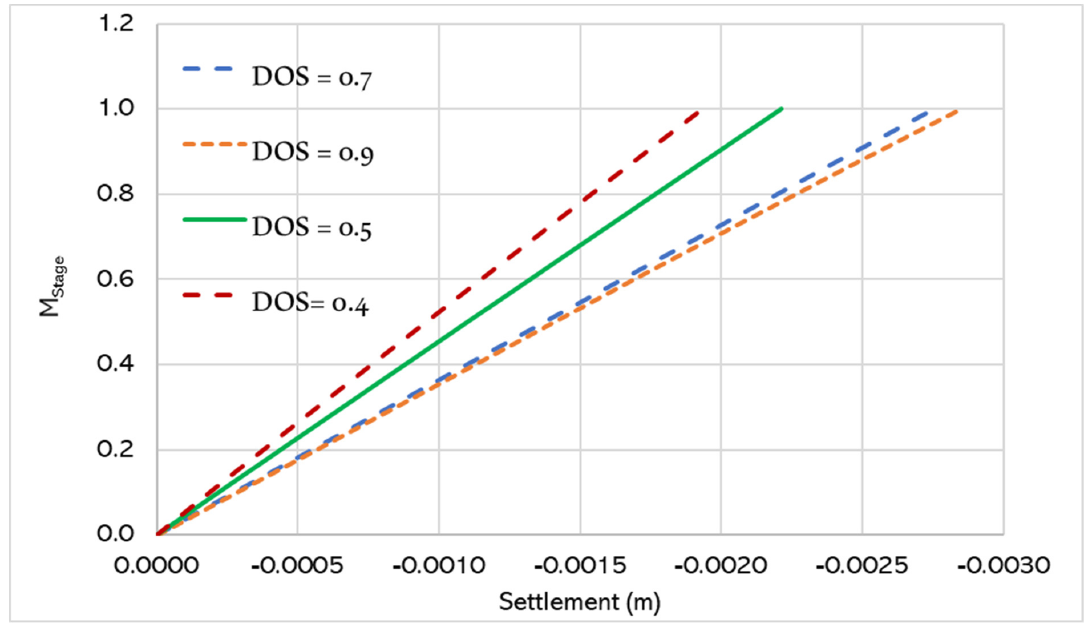
Figure 10. Effect of dry and unsaturated condition